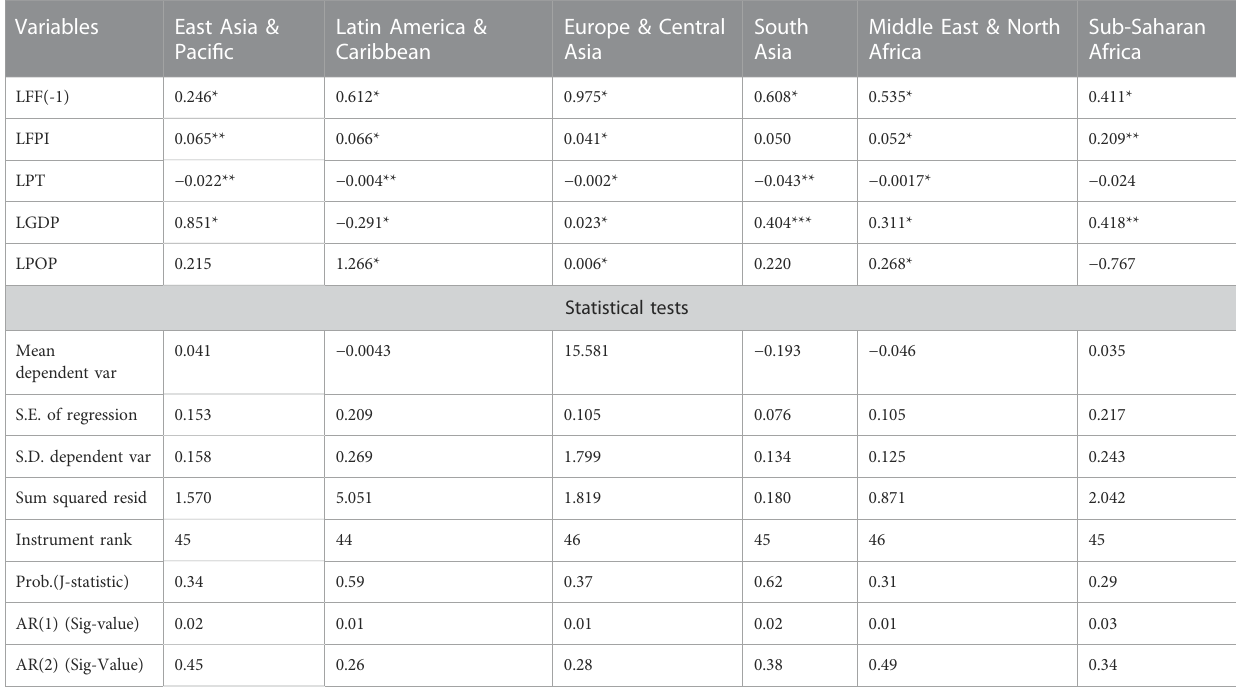
TABLE 6 Estimation Results of System GMM on regional